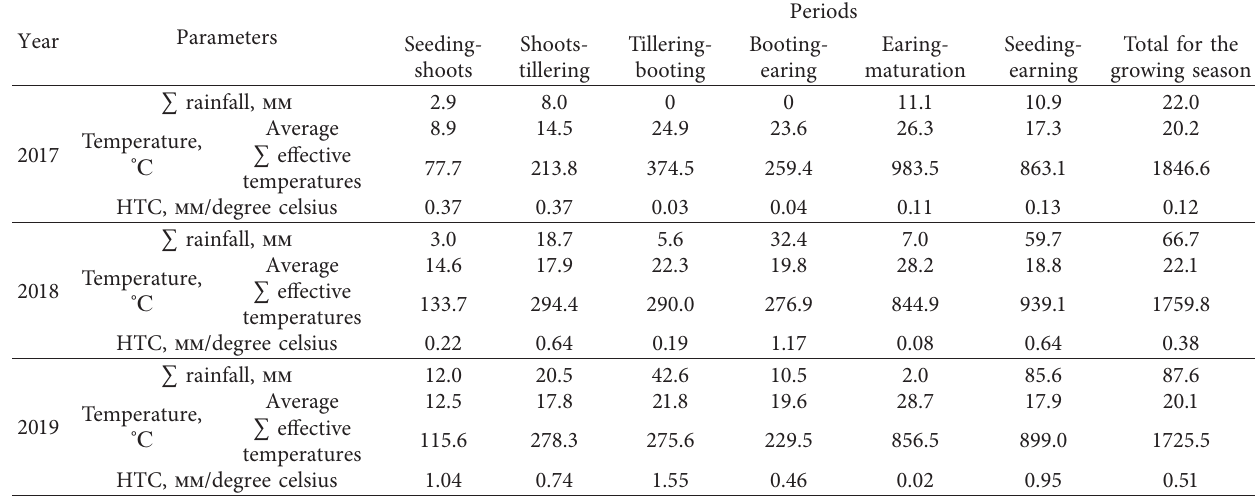
Table 1: Hydrothermal conditions of interphase periods of spring barley in